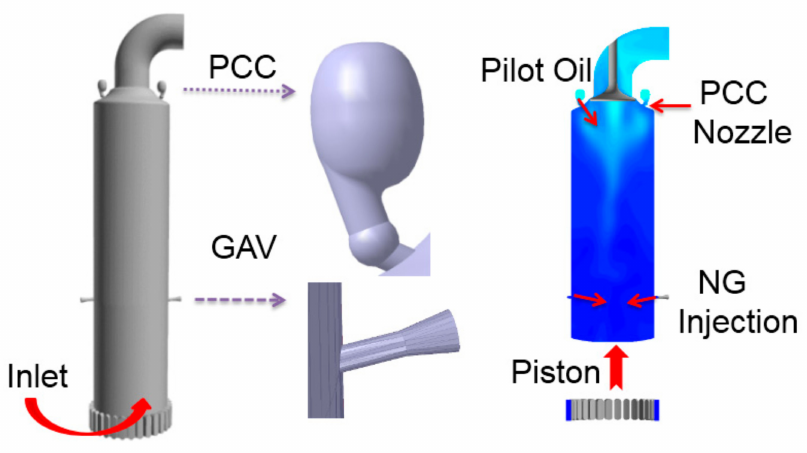
Figure 3. 3D analysis domain of a low-pressure dual-fuel (LP-DF)